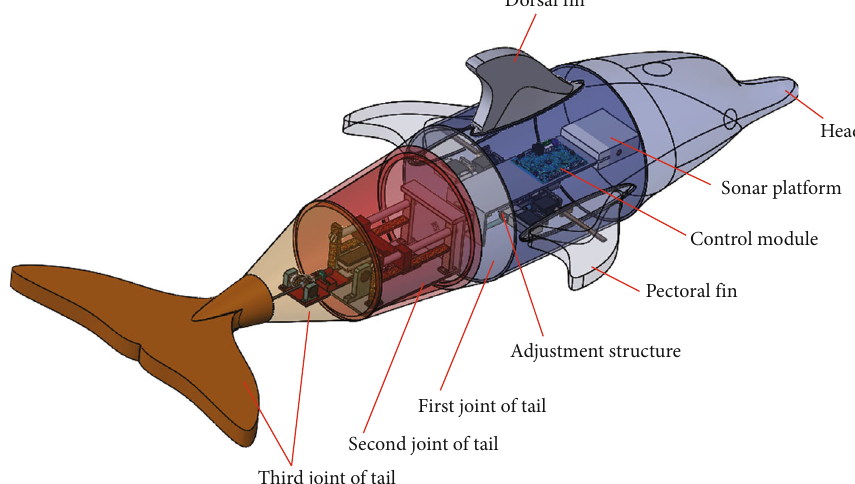
Figure 1: Three-dimensional distribution diagram of machine dolphin.